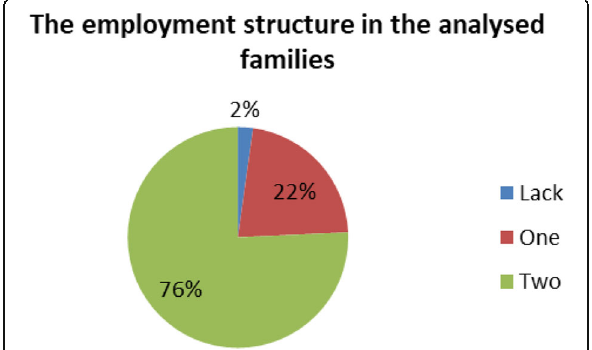
Fig. 1 The employment structure in the analysed families